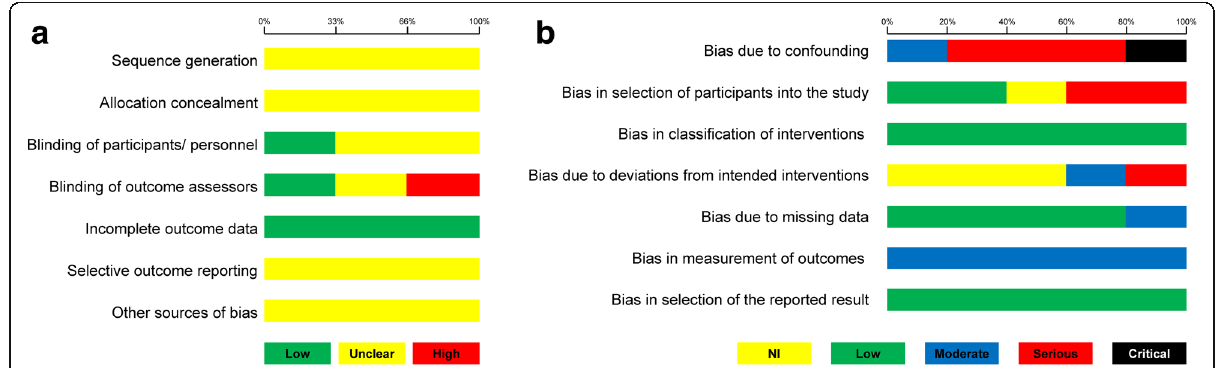
Fig. 2 a Risk of bias summary for included randomized trials with the Cochrane risk of bias tool. b Risk of bias summary for included non-randomized trials with the ROBIN-I